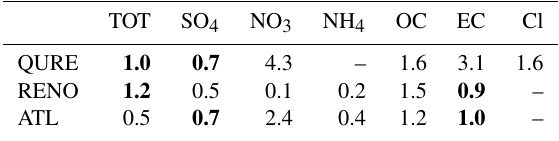
Table 3. The ratio of mean amplitude of the annual component r annual (CMAQ/observation). Boldface values indicate a magnitude with a ratio close to 1